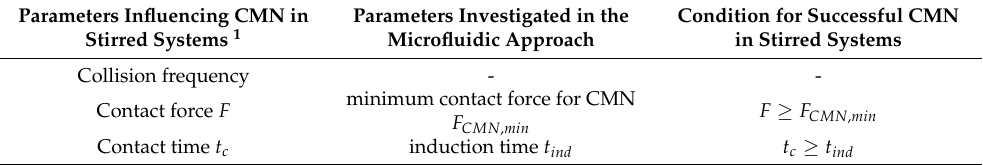
Table 2. Comparison of the parameters influencing the efficiency of contact-mediated nucleation (CMN) in stirred systems and the parameters that are investigated in the microfluidic system.